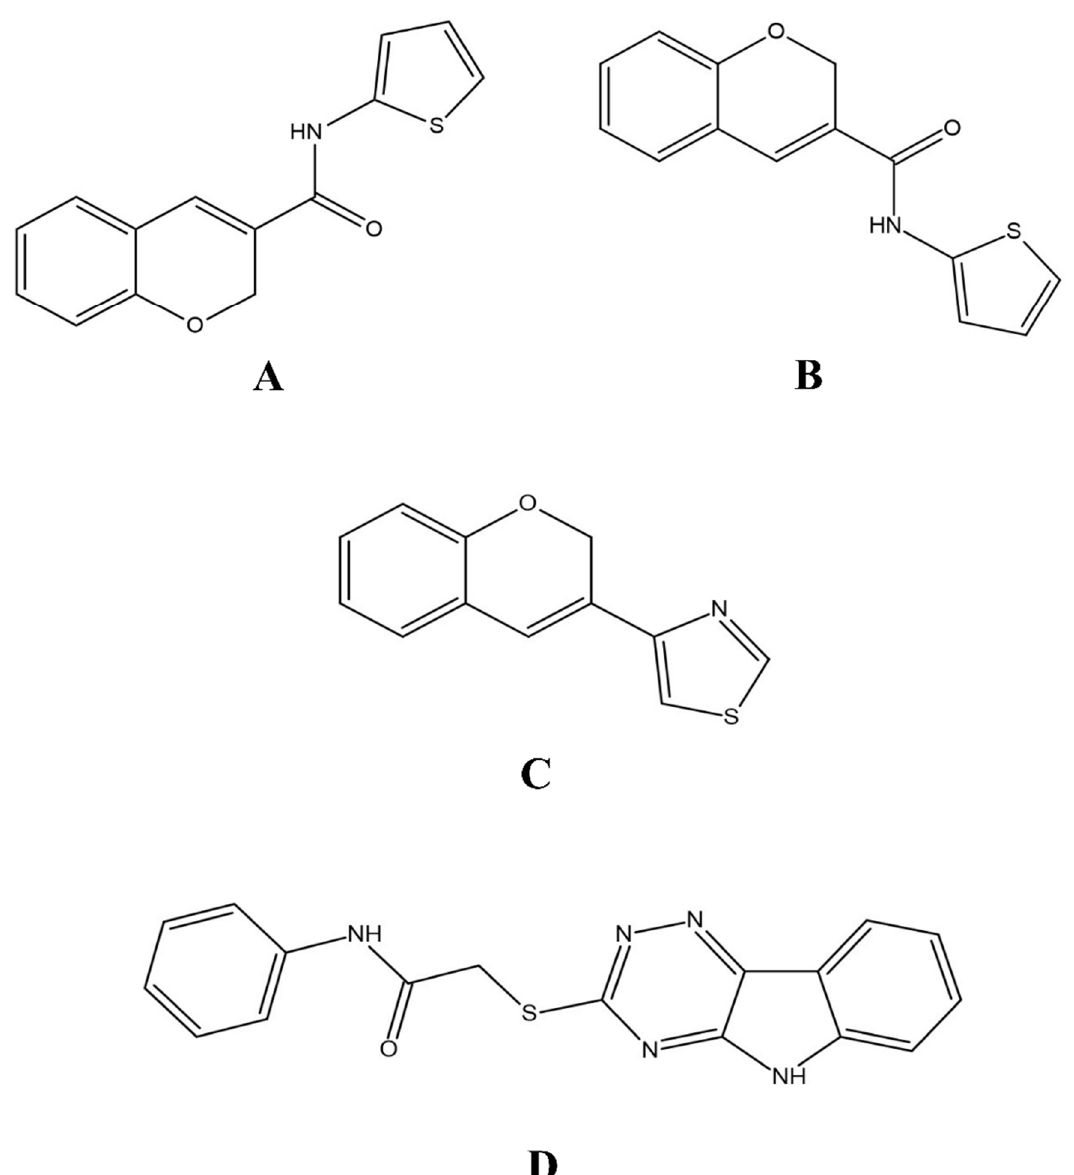
Figure 6. The 2D structures of the coumarin scaffolds obtained for the selected potential dual inhibitors from the ZINC database: ( A ) thiophenyl chromene carboxamide (scaffold of ZINC02789441), ( B ) thiophenyl chromene carboxamide with a different conformation (scaffold of